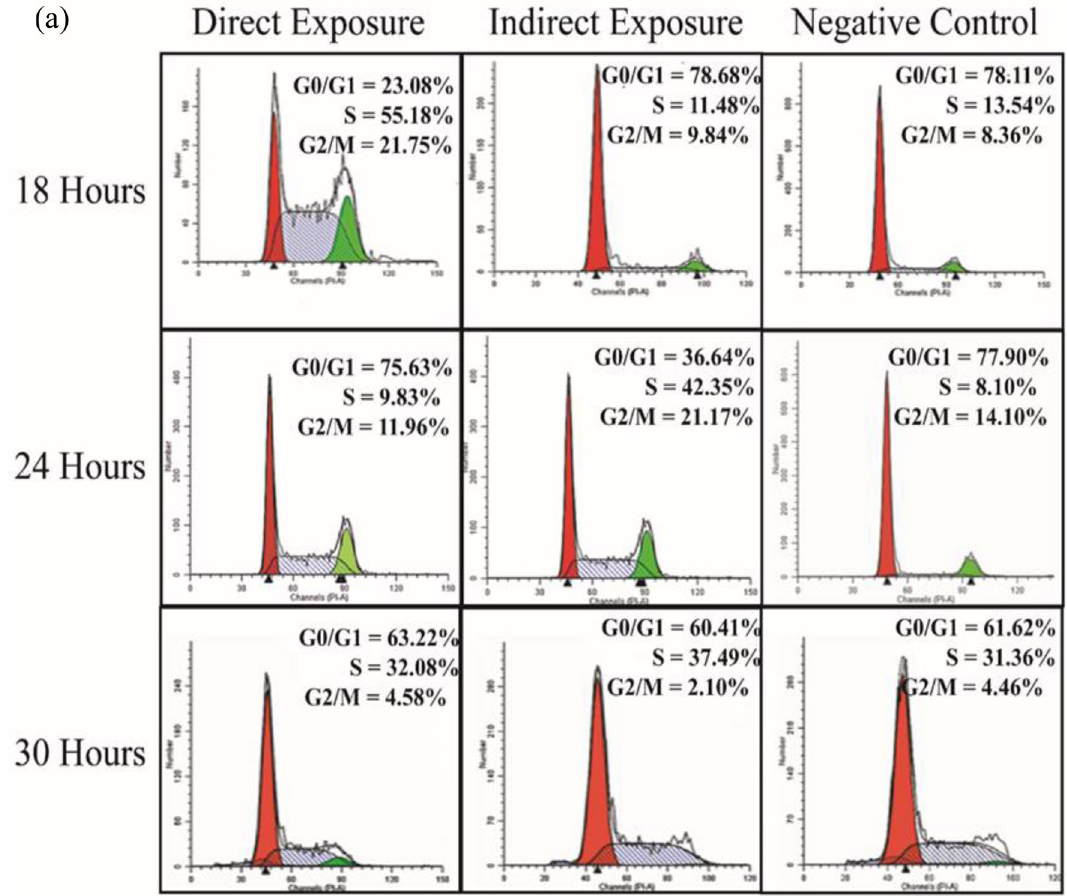
Figure 4. ( a ) DNA distribution showing cell cycle analysis of the MF exposed (DE and IE) as well as the control (NC) hUC-MSCs after 18, 24 and 30 h of culture. The cells in the DE were the first to progress into the cell cycle (as early as 18 h) as the G0/G1 phase markedly decreased while the S- and G2/M-phase increased. The trend was followed by the IE group at 24 h while the NC group lagged till 30 h. Graphical comparison between the cell cycle phases of the DE, IE and NC groups. ( b ) The picture shows the decreased G0/G1 phase and increased S- and G2/M phases in the DE group relative to the NC group after 18 h of culture. ( c ) Shows the decreased G0/ G1 phase and increased S- and G2/M phases in the IE group relative to the NC group after 24 h of culture, while ( d ) shows that there was no significant difference in cell cycle phases between the exposed and control groups. * Shows statistically significant increase in percentage of cells compared to the control (NC) while # shows statistical significant decrease in percentage of cells compared to the control (NC) ( p <